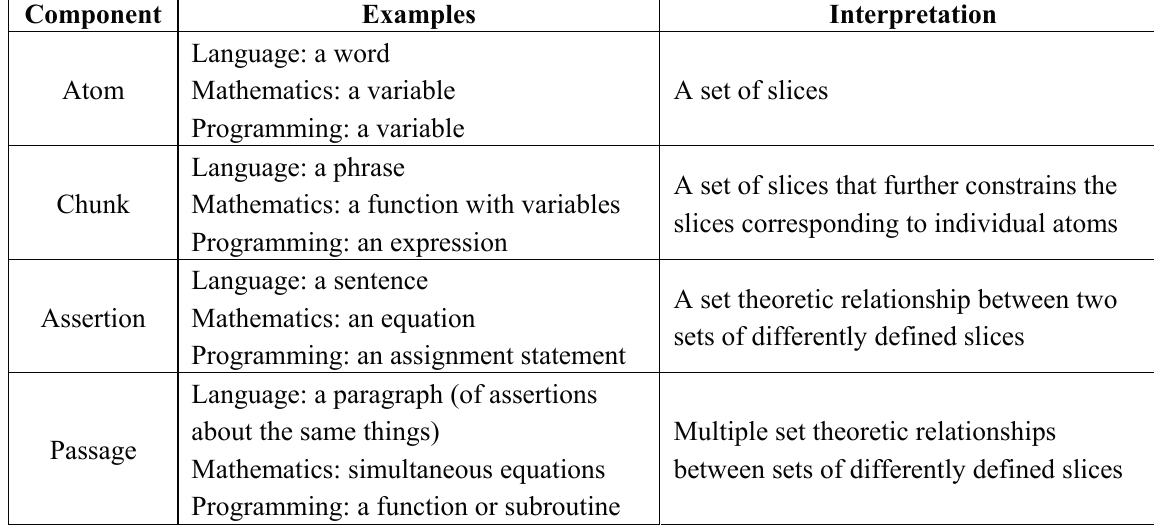
Table 2 . Types of modelling tool